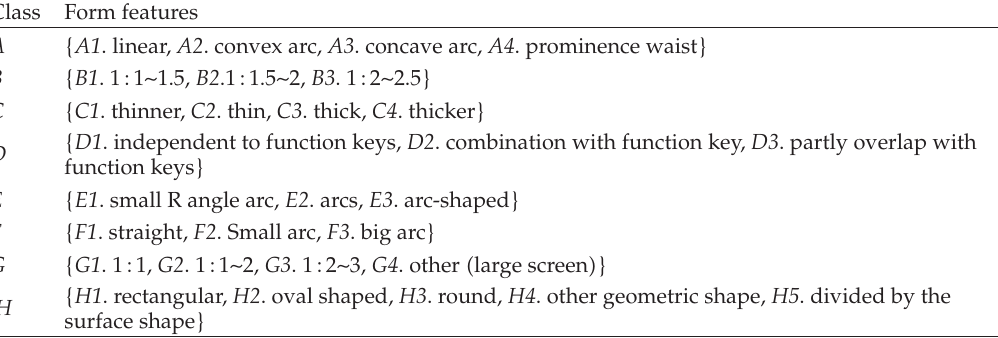
Table 2: Form classification and feature coding.